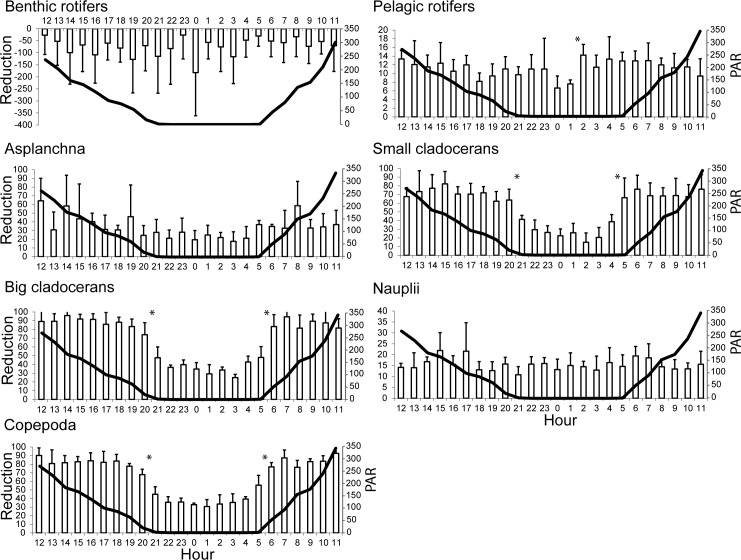
Mean + SD of the diurnal reduction in zooplankton abundance (%) in the outlet sections of the examined lakes in relation to the mean PAR values (μmol photons m−2s−1) (solid line).* P < 0.05, significant differences in the reduction rates for the subsequent hours.